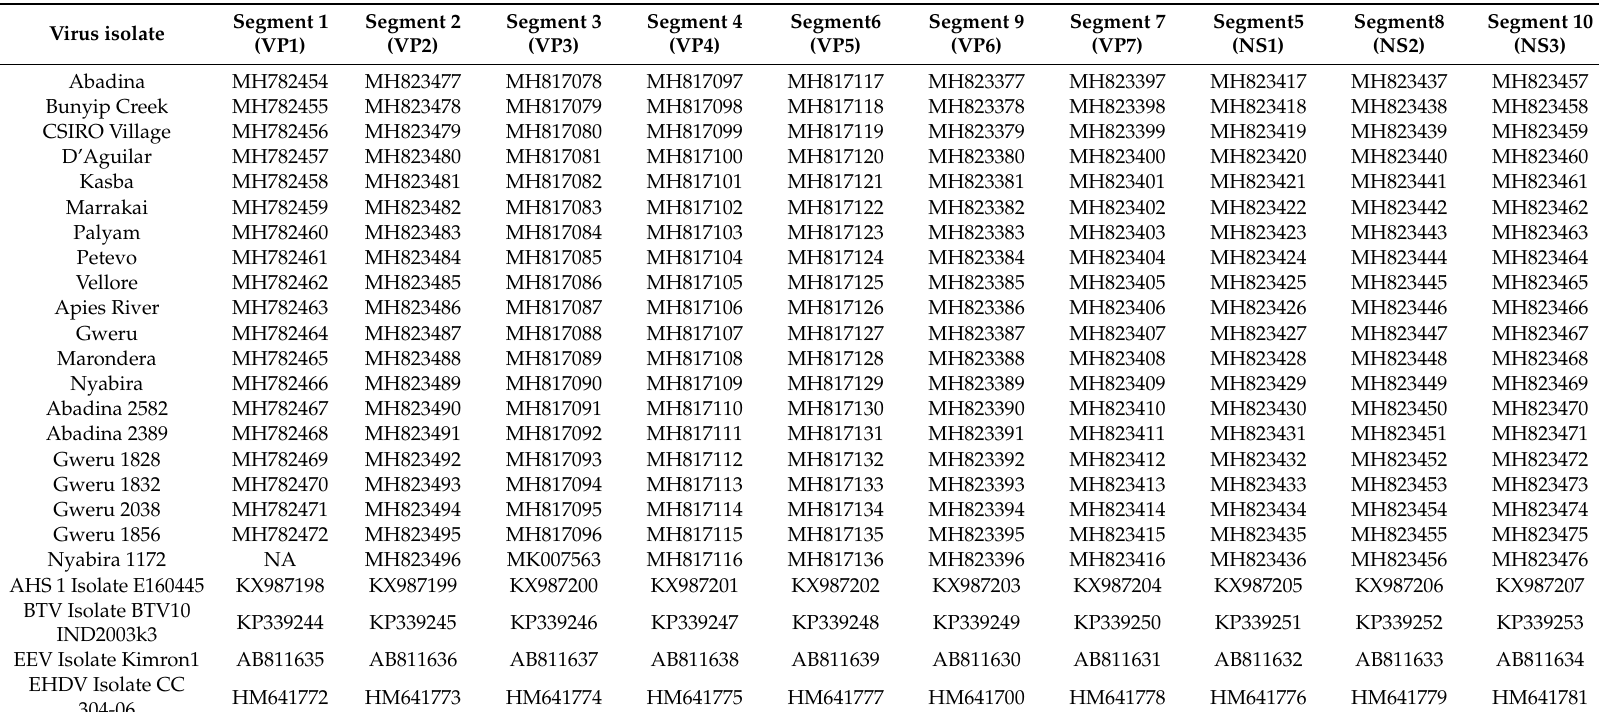
Table 2. Accession numbers of Palyam virus sequences submitted to GenBank and other orbiviruses used in the